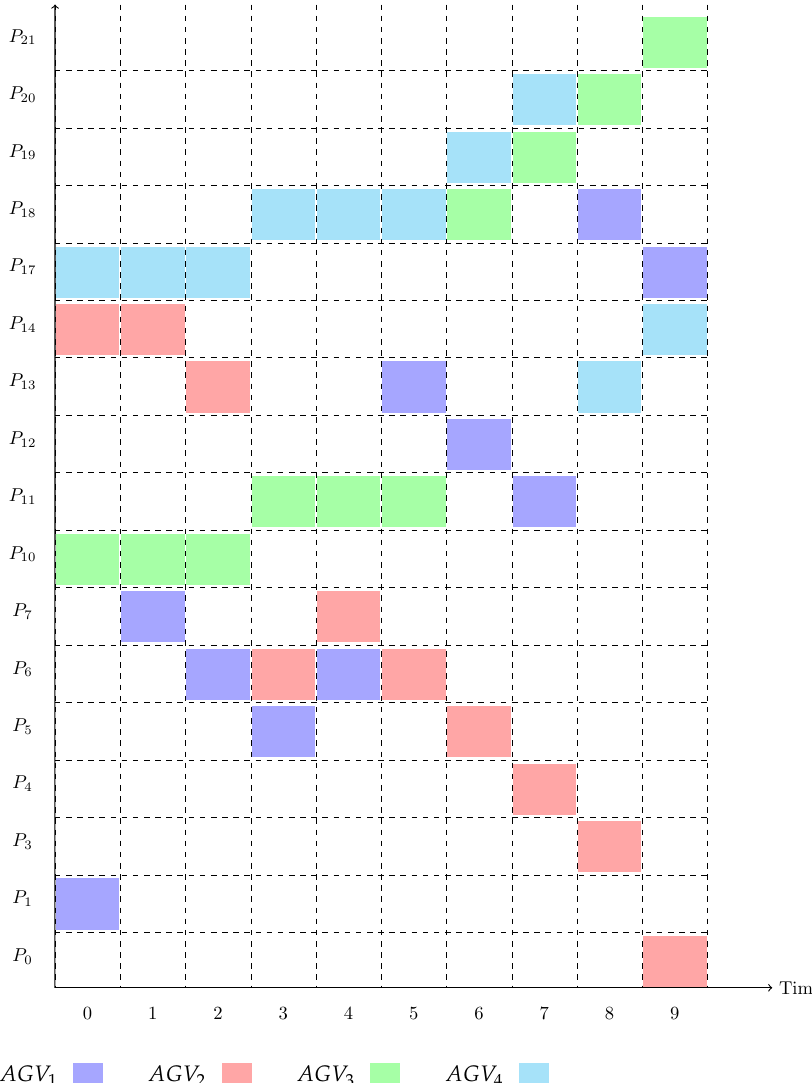
Figure 6. Simulation output: places held by the AGVs in each time